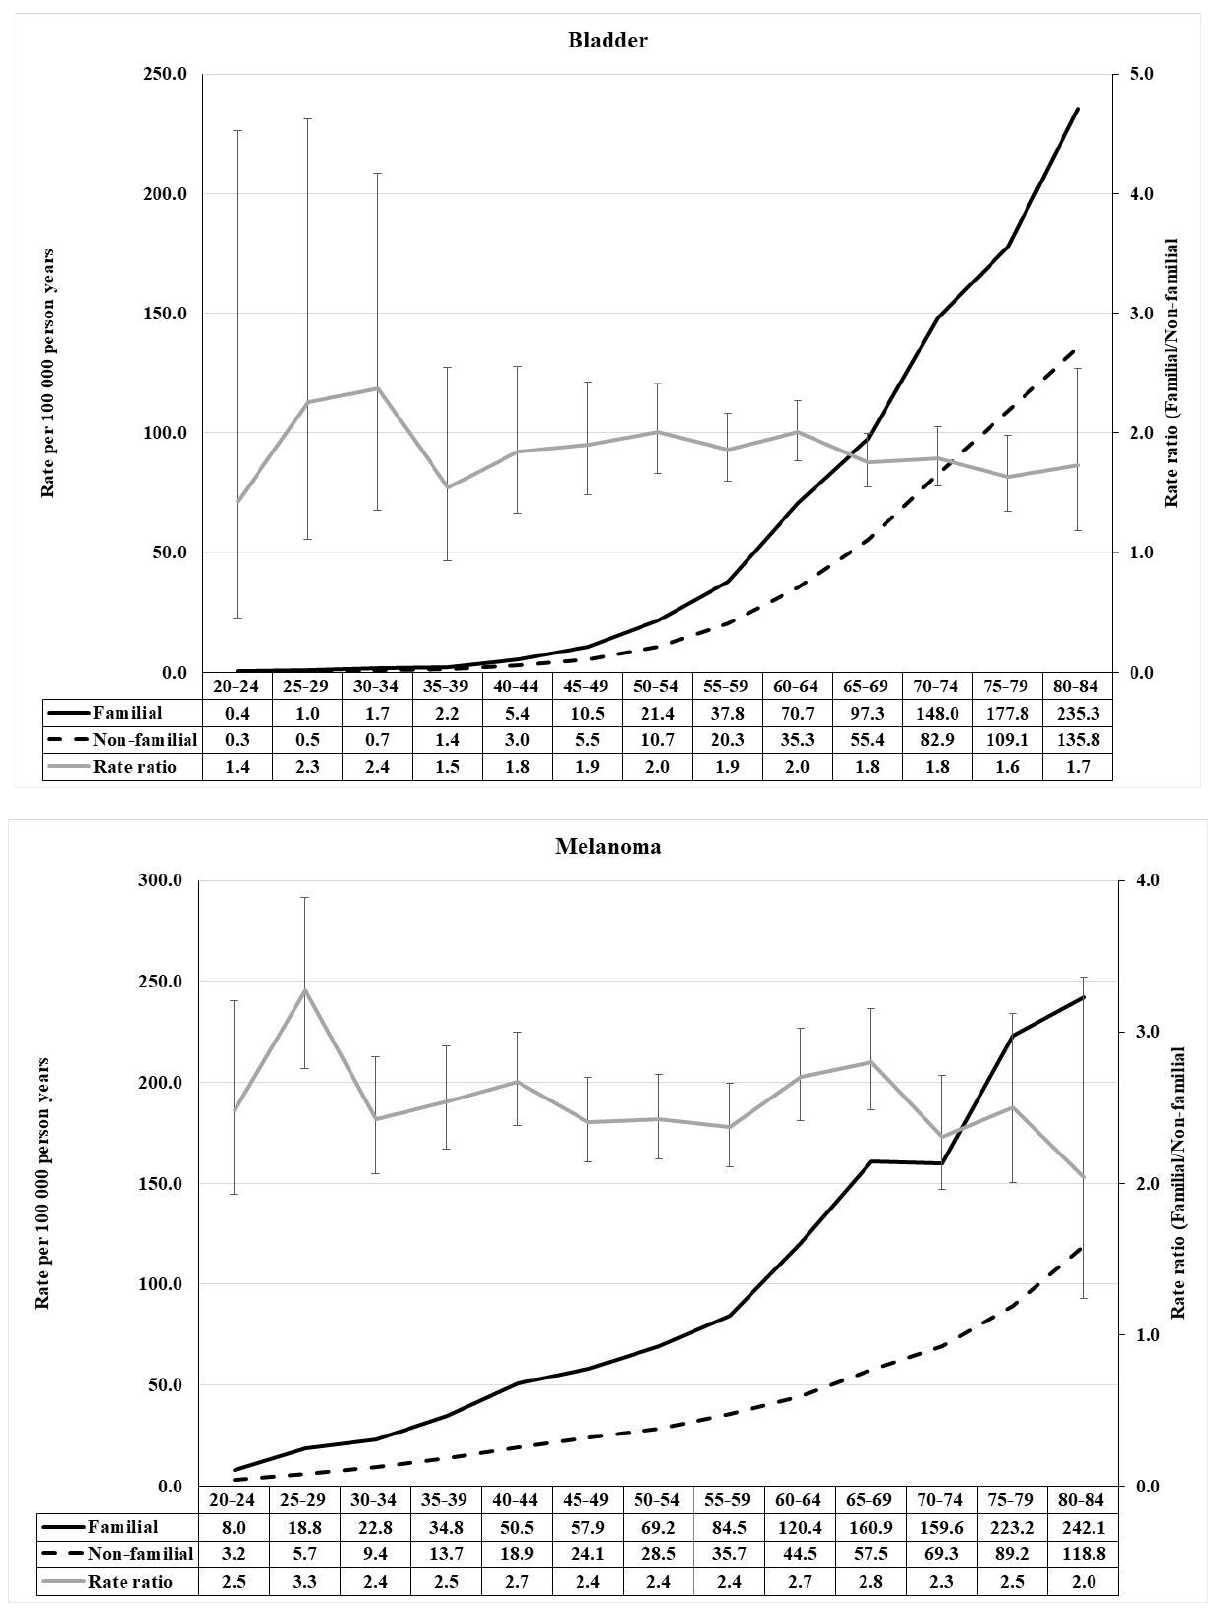
Figure 5. Age-specific incidence rate and rate ratio of bladder (urinary bladder) cancer ( upper ) and melanoma ( lower ) in population with and without family history of concordant cancer.